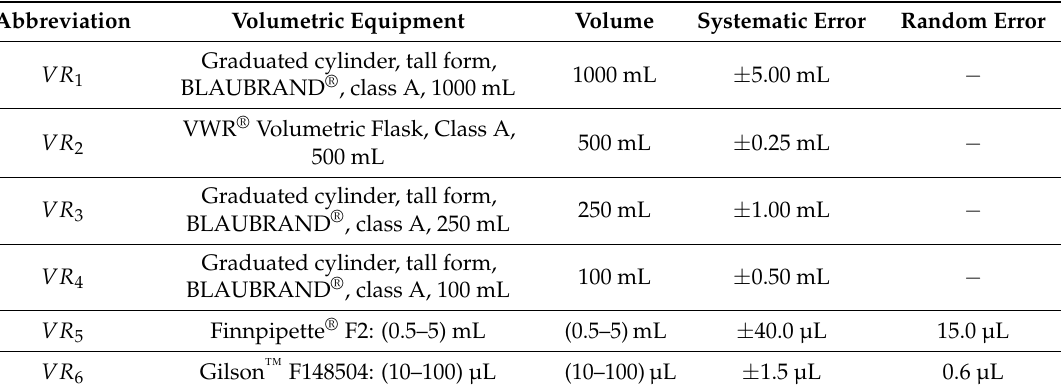
Table 6. A list of the six different equipment used for preparing the samples of the experiment seen in Figure 13, and the corresponding systematic and random